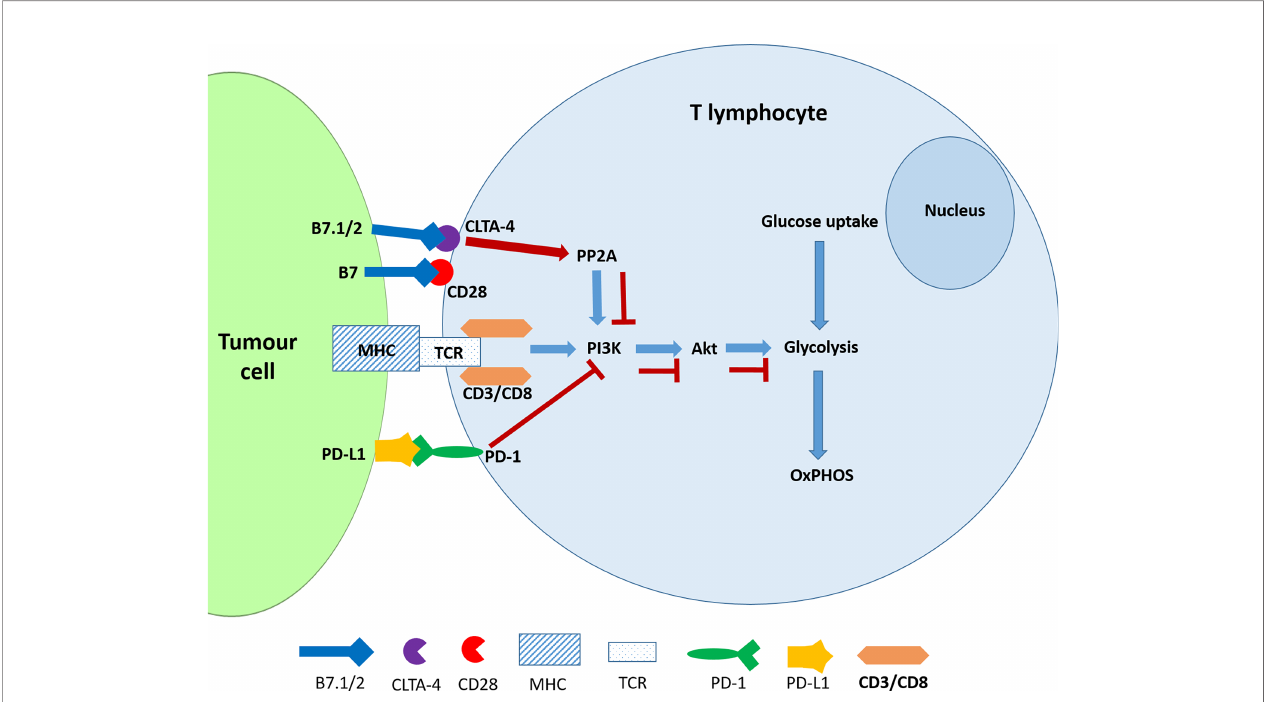
FIGURE 1 | CTLA-4 and PDL-1 ligation interferes with glucose metabolism in activated T cells. The ligation of PD-1 blocks the activation of PI3K and consequently the Akt signalling pathway resulting the inhibition of glycolysis. CTLA-4 accomplishes the same outcome by activating the phosphatase